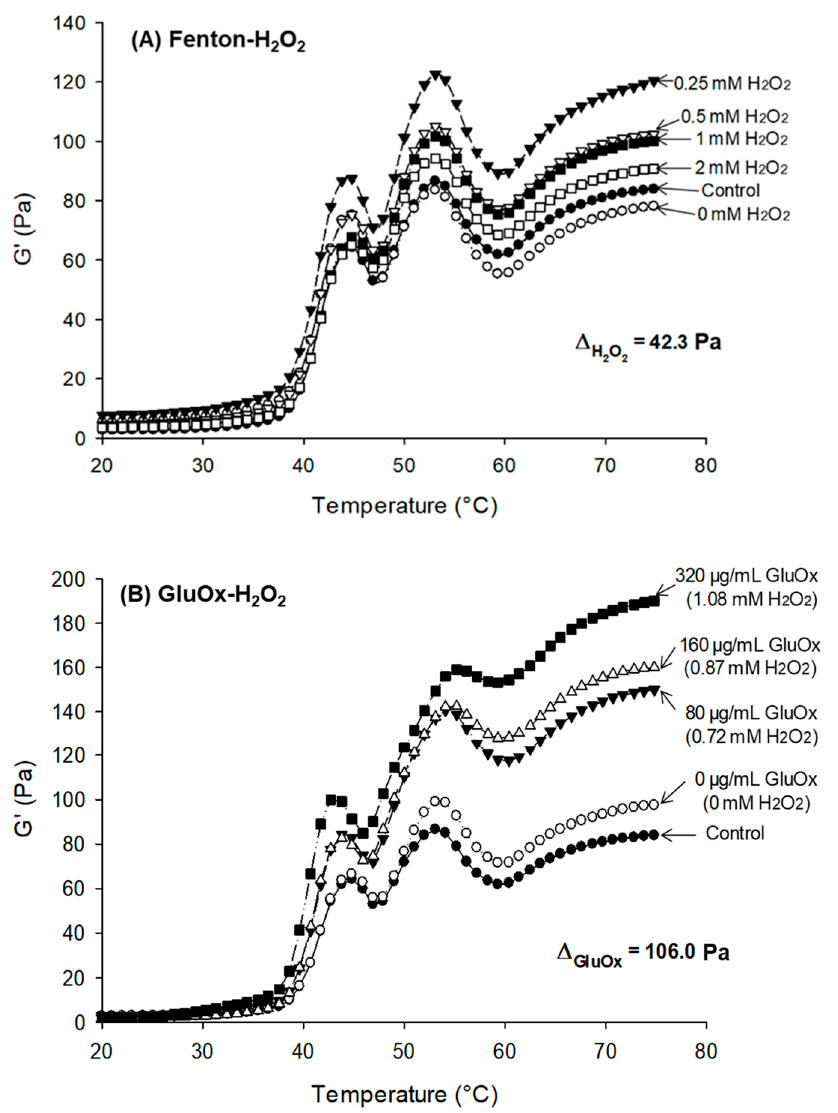
Figure 3. Storage modulus (G ′ ) development of oxidatively modified myofibrillar protein during thermal gelation. ( A ) oxidation in a Fenton system (FeCl 2 /H 2 O 2 ); ( B ) oxidation in a glucose oxidase (GluOx) system. ∆ denotes the differential between the highest and lowest final G ′ values. Ref: Wang et al. [44].